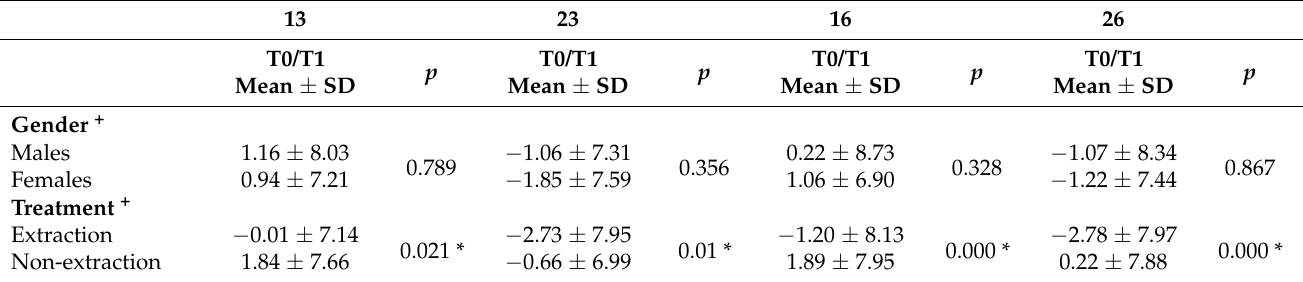
Table 9. Comparison of T0/T1 angulation differences of teeth 13, 23, 16, and 26 between groups for gender, skeletal, and angle